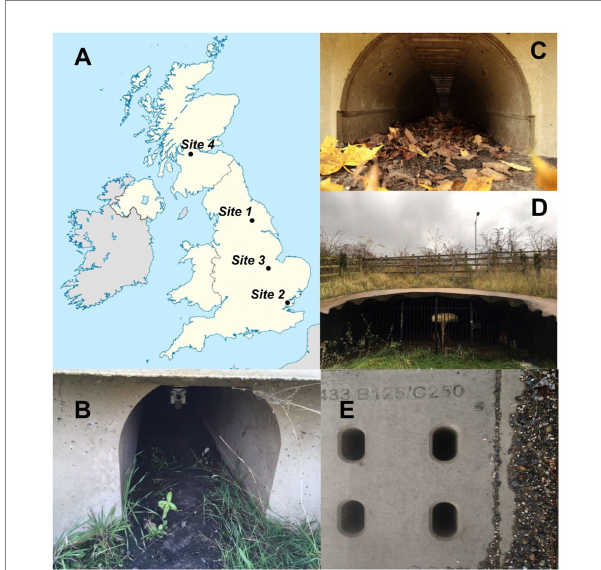
FIGURE 1 Site location (A) and example images of sample locations. (B) sediment build up in ACO tunnel entrance at Site 1; (C) ACO tunnel entrance showing grid at the top providing opening to the road surface above (Site 1); (D) larger concrete culverts – one of the two types of underpass installed at Site 3; (E) Road surface at Site 1 showing dust build up (right of image) and apertures in tunnel to provide light (and unintentional pollutant